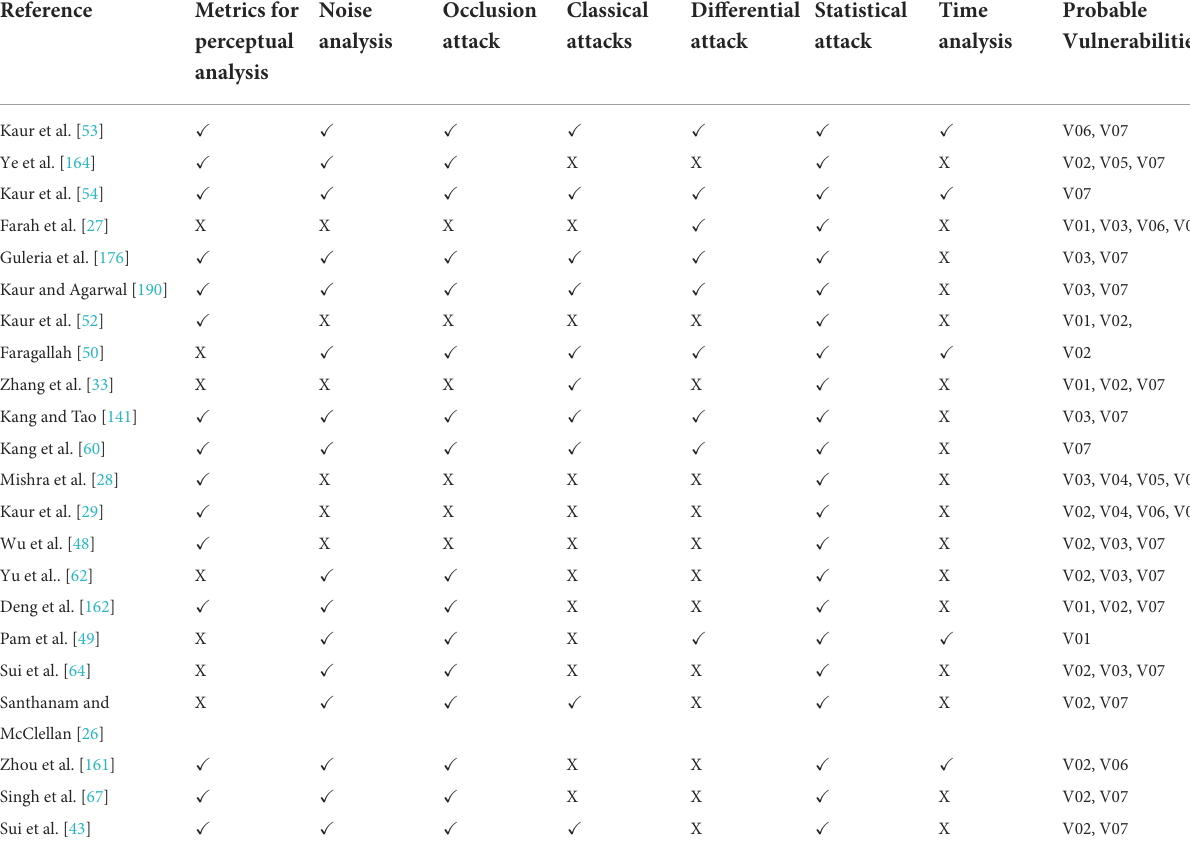
TABLE 9 Comparative analysis for subjective parameters (refer Table 8 for performance metrics).